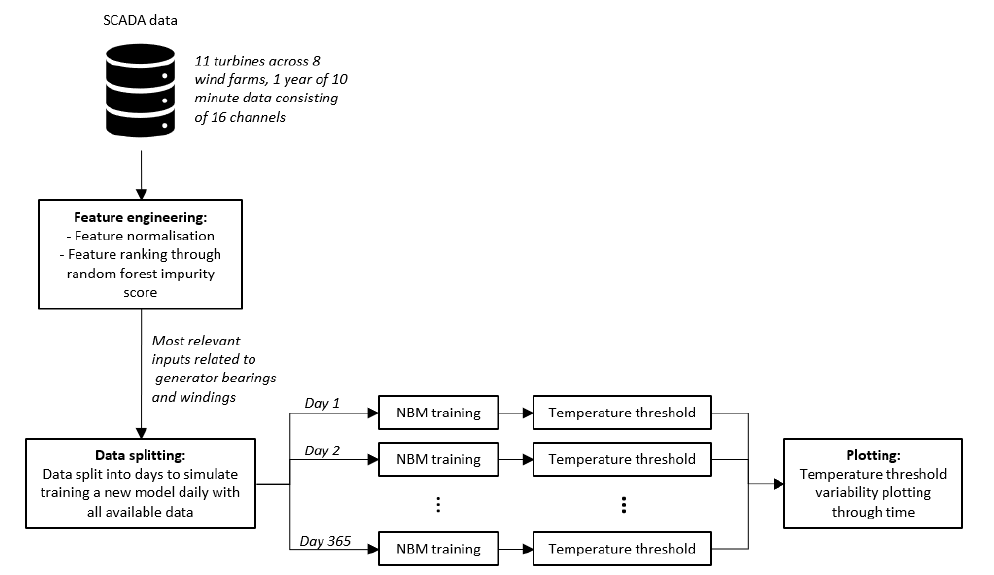
Figure 1. Methodology for generating NBM temperature